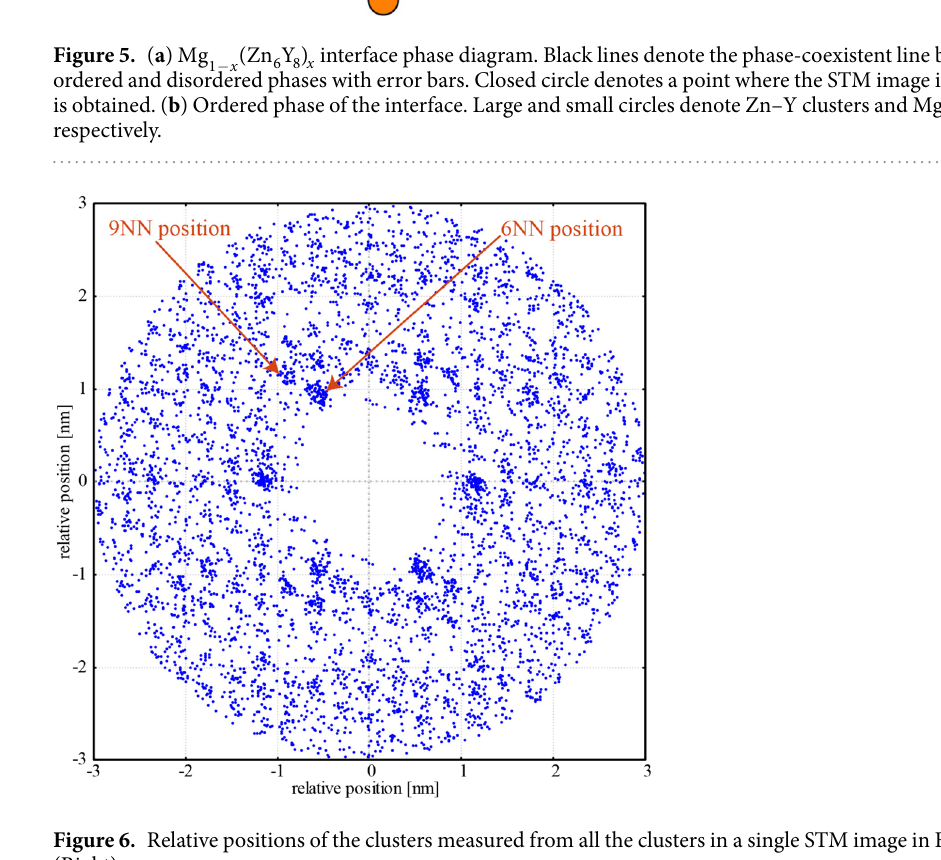
Figure 6. Relative positions of the clusters measured from all the clusters in a single STM image in Fig. 1